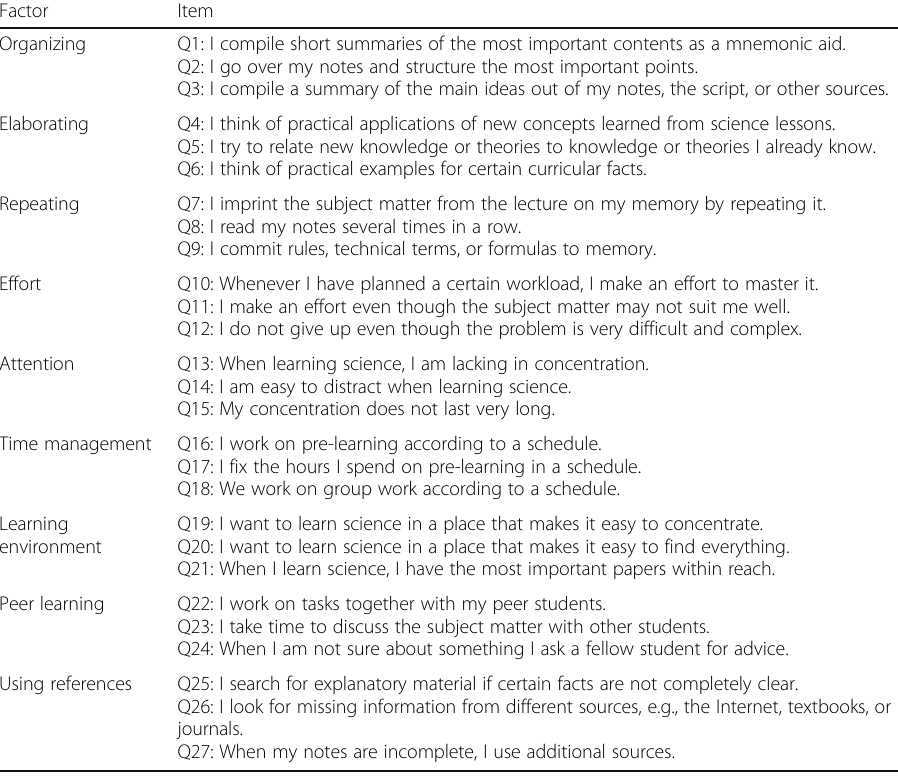
Table 11 Items of the STEM Learning Strategy (SLS) Questionnaire